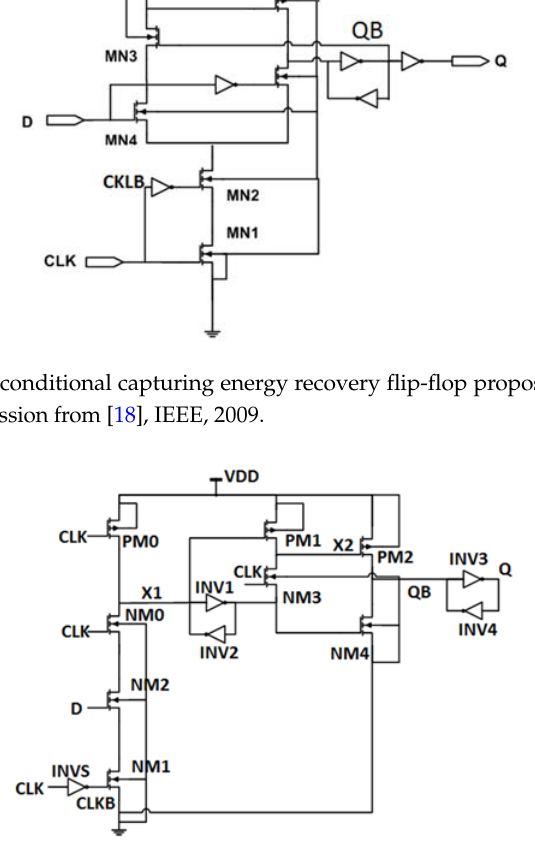
Figure 4. Dual dynamic node flip-flop proposed by Absel et al. Reproduced with permission from [19], IEEE,